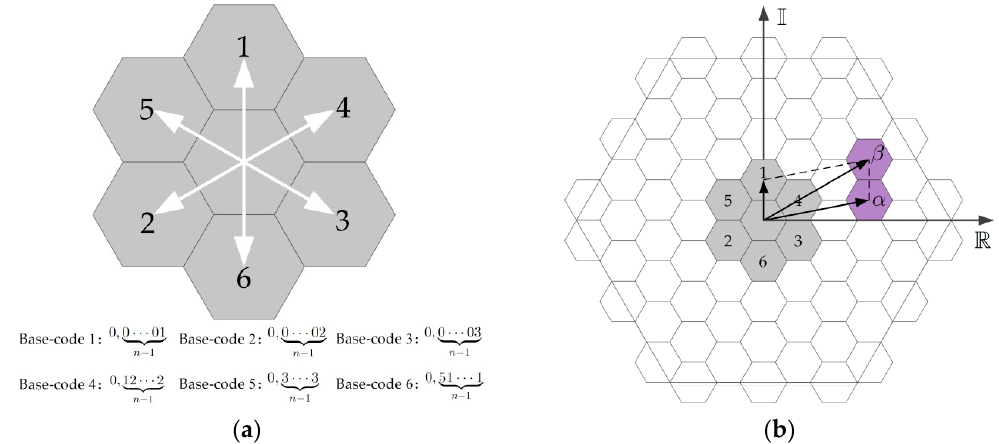
Figure 4. Code addition structure and neighboring cell code calculation: ( a ) code addition structure (with n denoting level) and ( b ) calculation of the neighboring cell code.